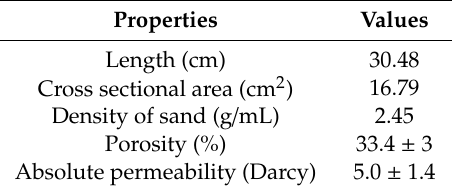
Table 1. Properties of the cylindrical sandpack and the packing material at ambient